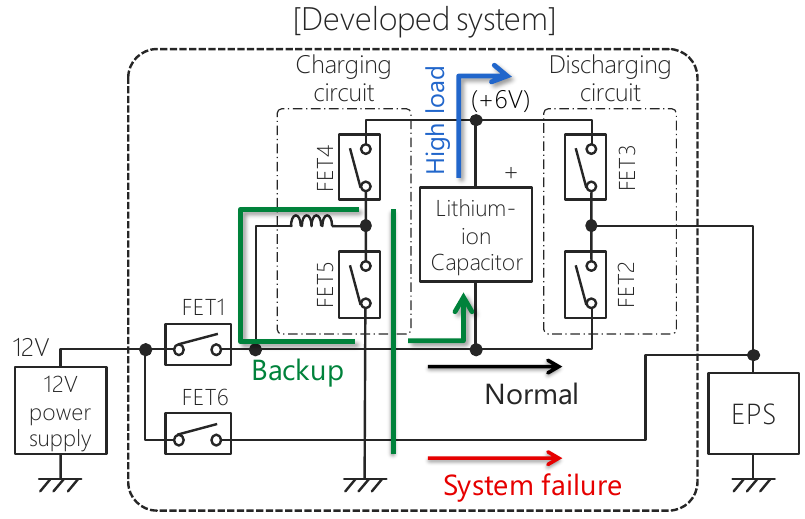
Figure 5. Circuit operation of charge/discharge controller.